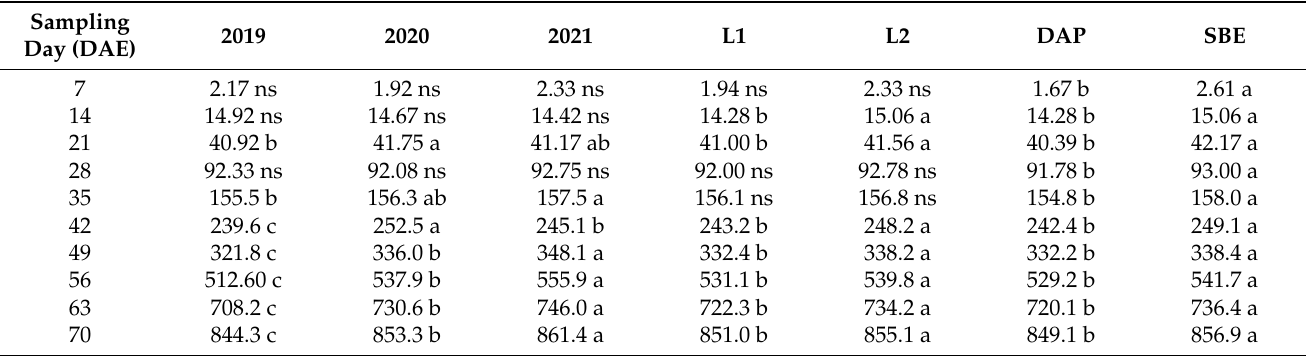
Table 3. Dynamics (from 7 to 70 DAE) of the aerial biomass production (g DM m − 2 ) for each growing season, location, and applied fertilizer.